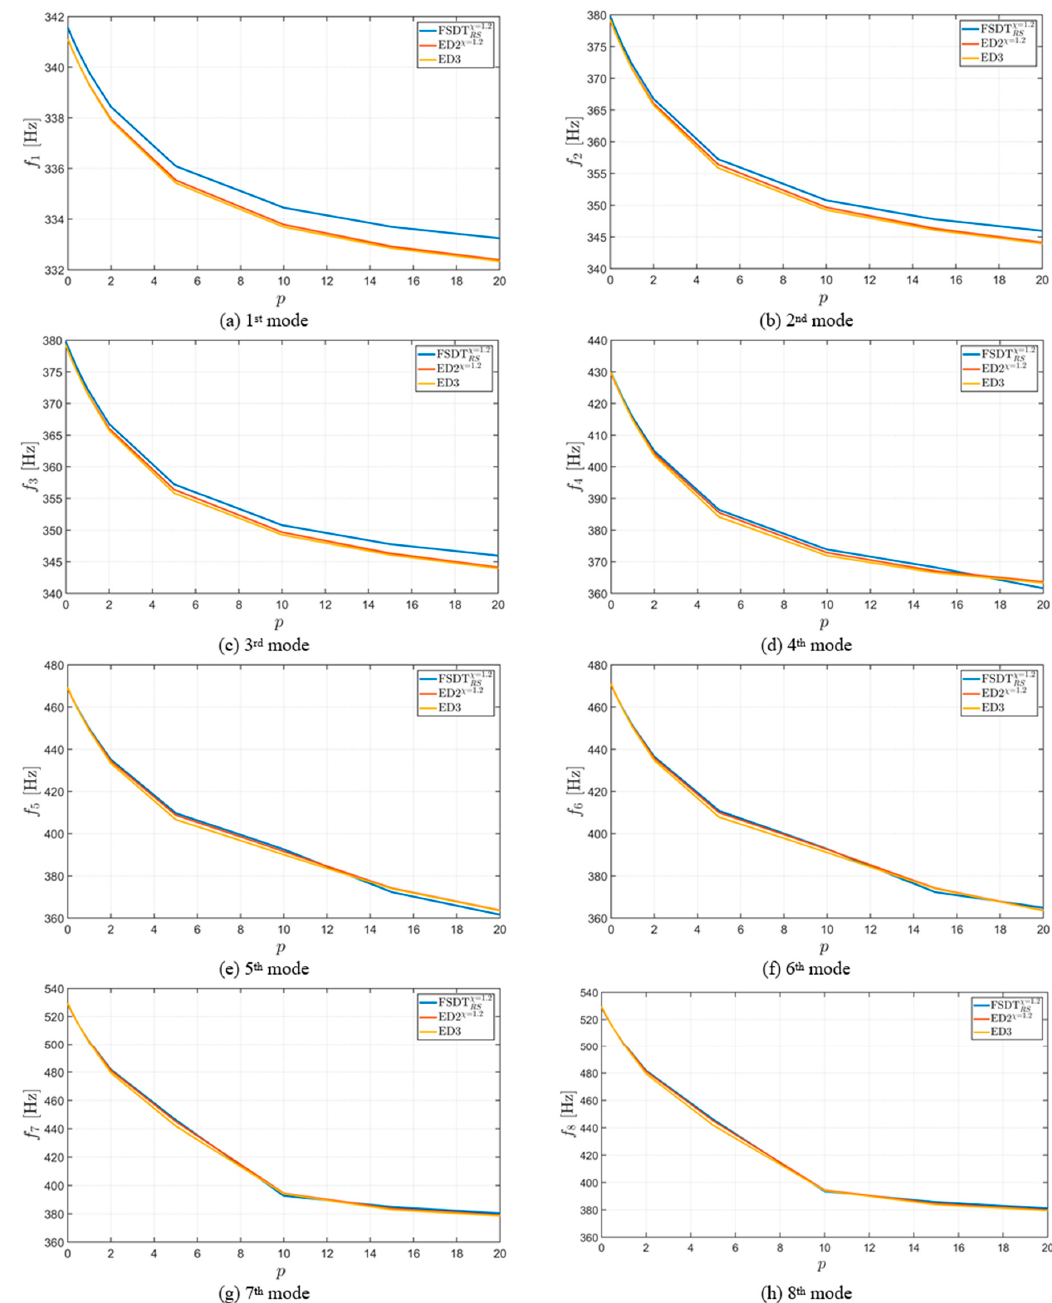
Figure 6. Frequency variations of a CCCC square plate (Figure 3a) made of one lamina of constant thickness h = 0.1m; reinforced by CNTs distributed as in Figure 5a for the different parameters p ( k ) . The mass fraction was w r = 0.05, and the agglomeration parameters µ 1 = µ 2 = 1. The Chebyshev-Gauss-Lobatto grid distribution was employed, with I N = I M = 21. The following mode shapes are considered: ( a ) 1st mode; ( b ) 2nd mode; ( c ) 3rd mode; ( d ) 4th mode; ( e ) 5th mode; ( f ) 6th mode; ( g ) 7th mode; ( h ) 8th mode.